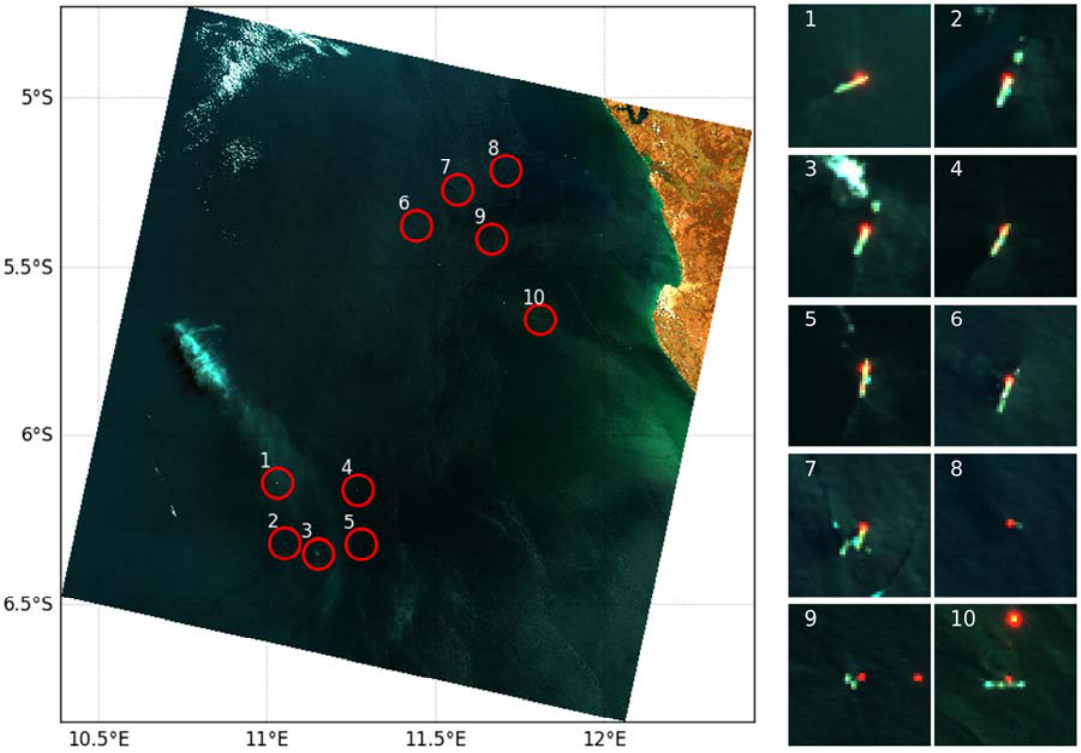
Figure 7. Landsat OLI false colour composite (R: Band 6 G: Band 3 B: Band 2) covering the 10 locations of gas flaring detected by the Landsat-8 OLI sensor on the 27 April 2015 at 09:22 UTC.